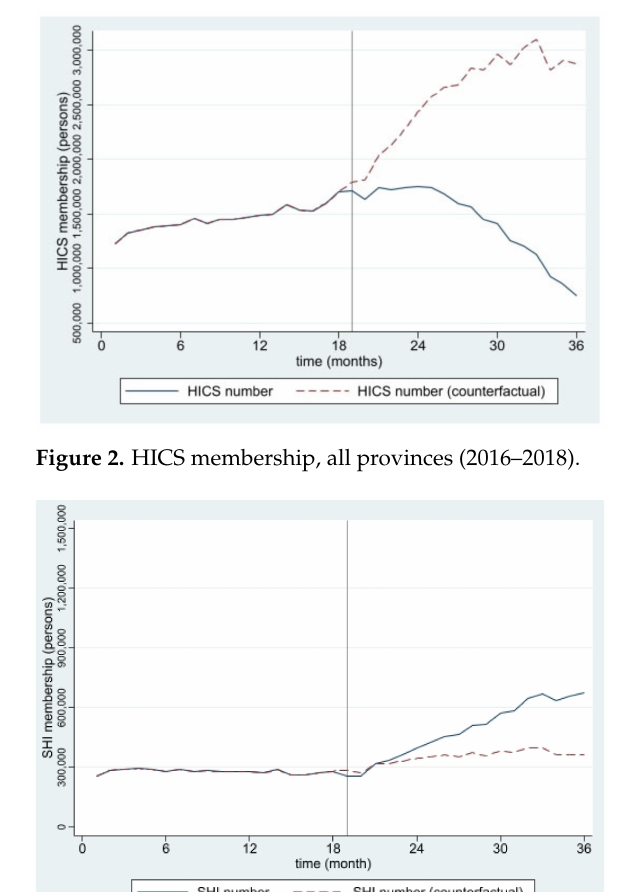
Figure 1. SHI membership, all provinces (2016–2018).